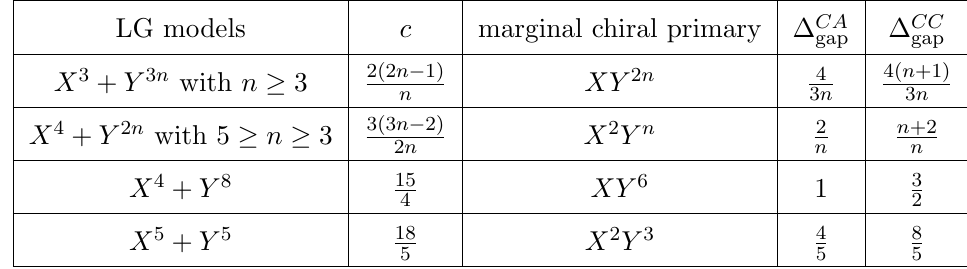
Table 2. CA and CC gaps in